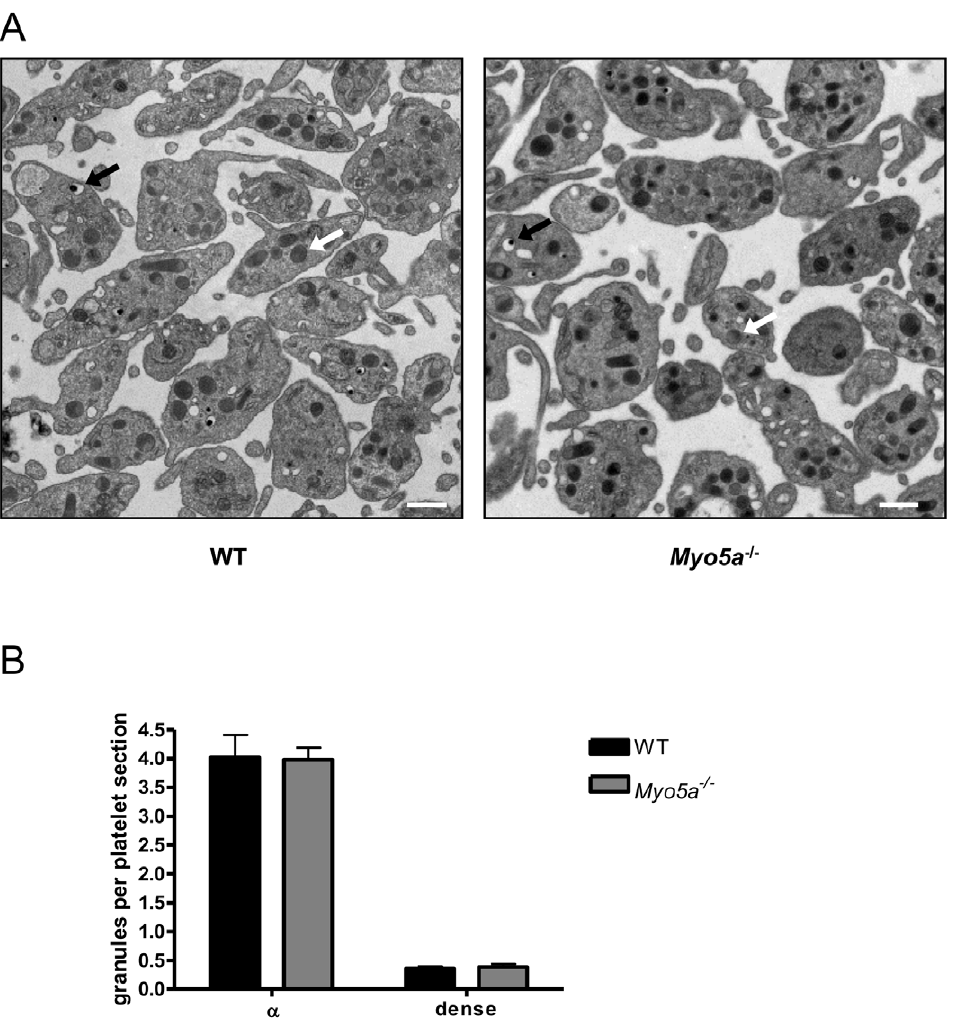
Figure 2. Myo5a 2 / 2 platelets have normal subcellular morphology. (A) TEM images (4800 6 , scale bar: 1 m M) show representative images of WT and Myo5a 2 / 2 mouse platelets (n=4). Black arrows: dense granules. White arrows: a -granules. (B) Platelet dense and a -granules were quantified per field of view (10 fields of view per preparation) and data (mean + / 2 SEM, n=4) are shown as the number of granules per platelet visible in the section. This number is for comparison between genotypes only, as granules above or below the thin section plane will not be visible, and so